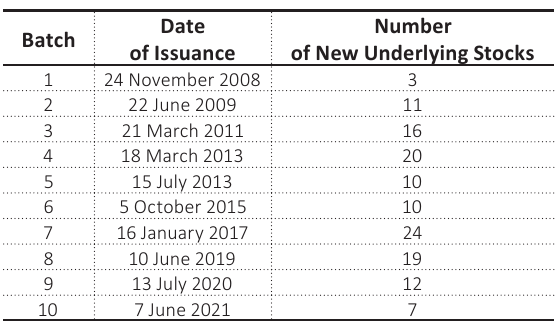
Table 4. Date of issuance and number of